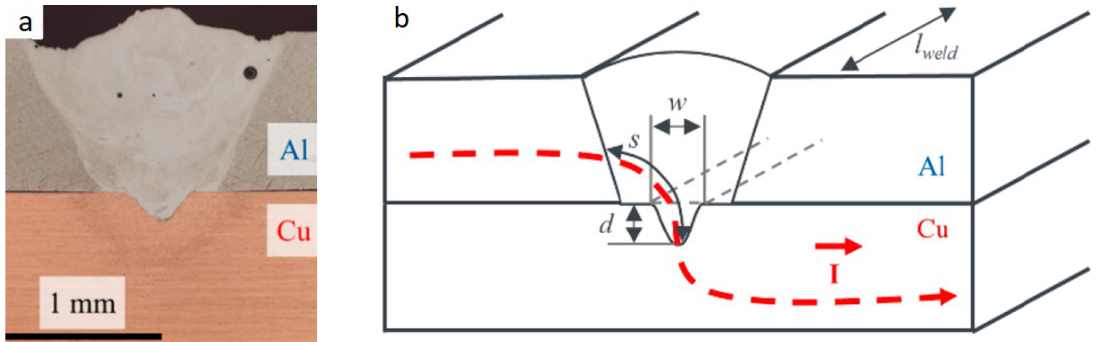
Figure 19. Welded joint of aluminum and copper: ( a ) macrostructure, ( b ) geometrical parameters of the weld seam [69].